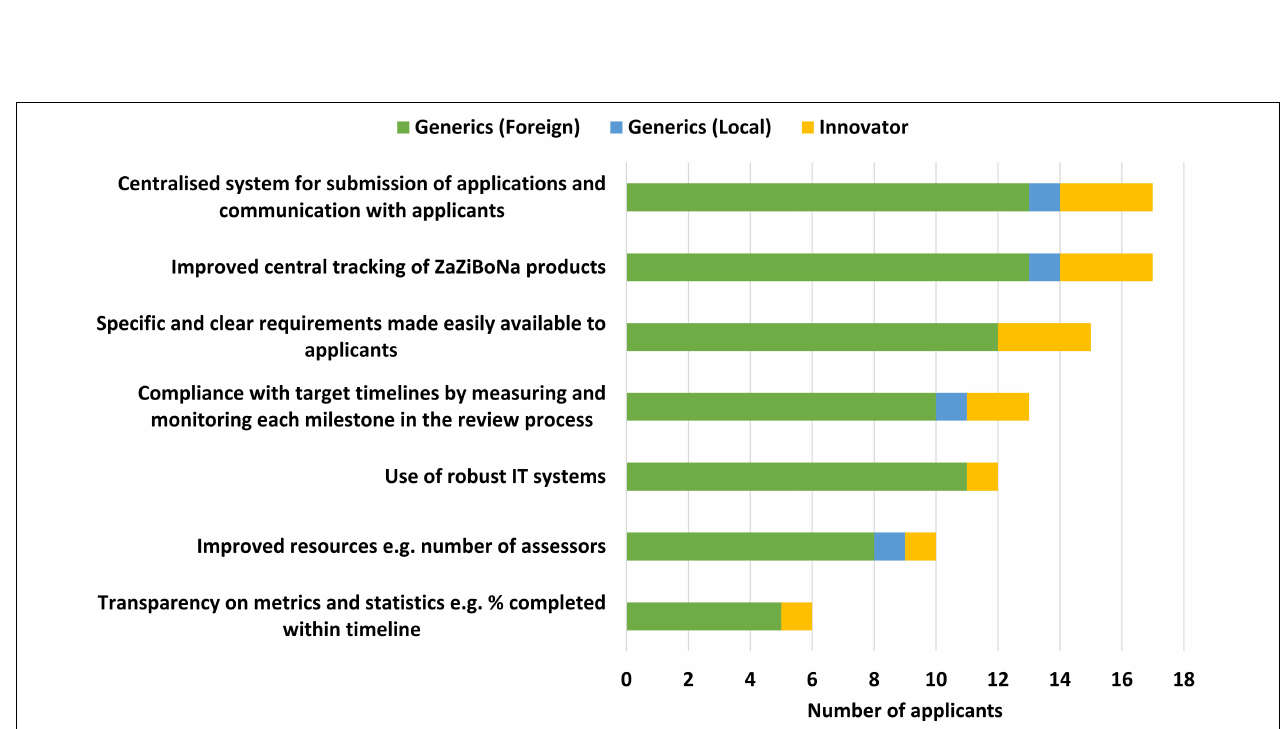
FIGURE 6 | Improving the efficiency of the ZaZiBoNa initiative according to pharmaceutical industry respondents.